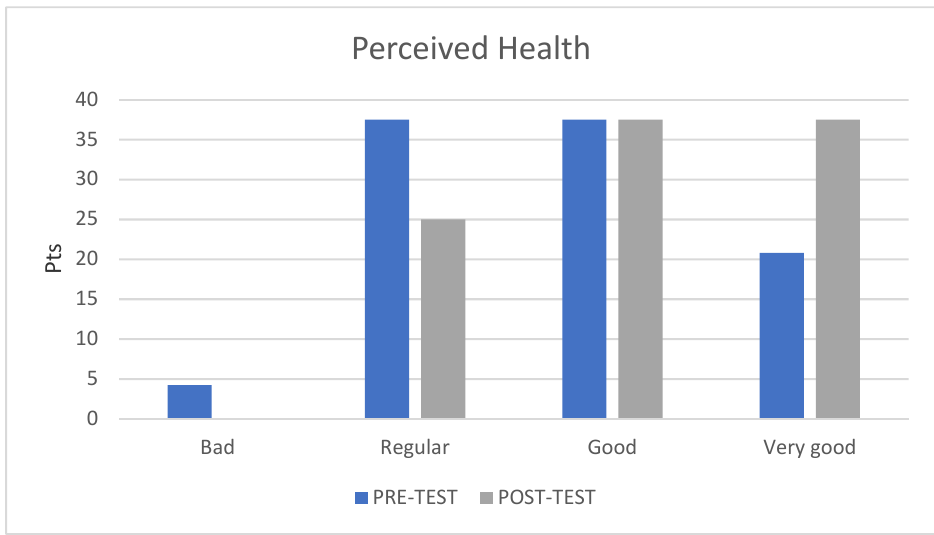
Figure 4. Variation in perceived health; Pts =